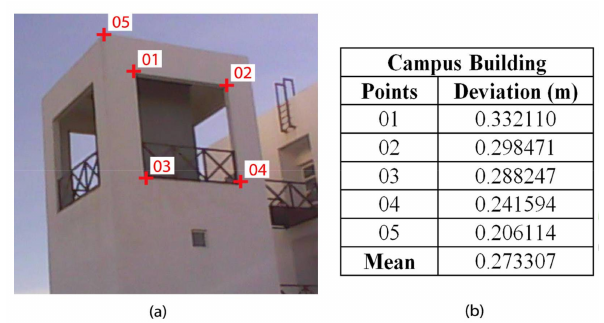
Figure 13. Accuracy assessment via GCP of the campus building: ( a ) GCP distribution; and, ( b ) deviations of the GCP along with their mean